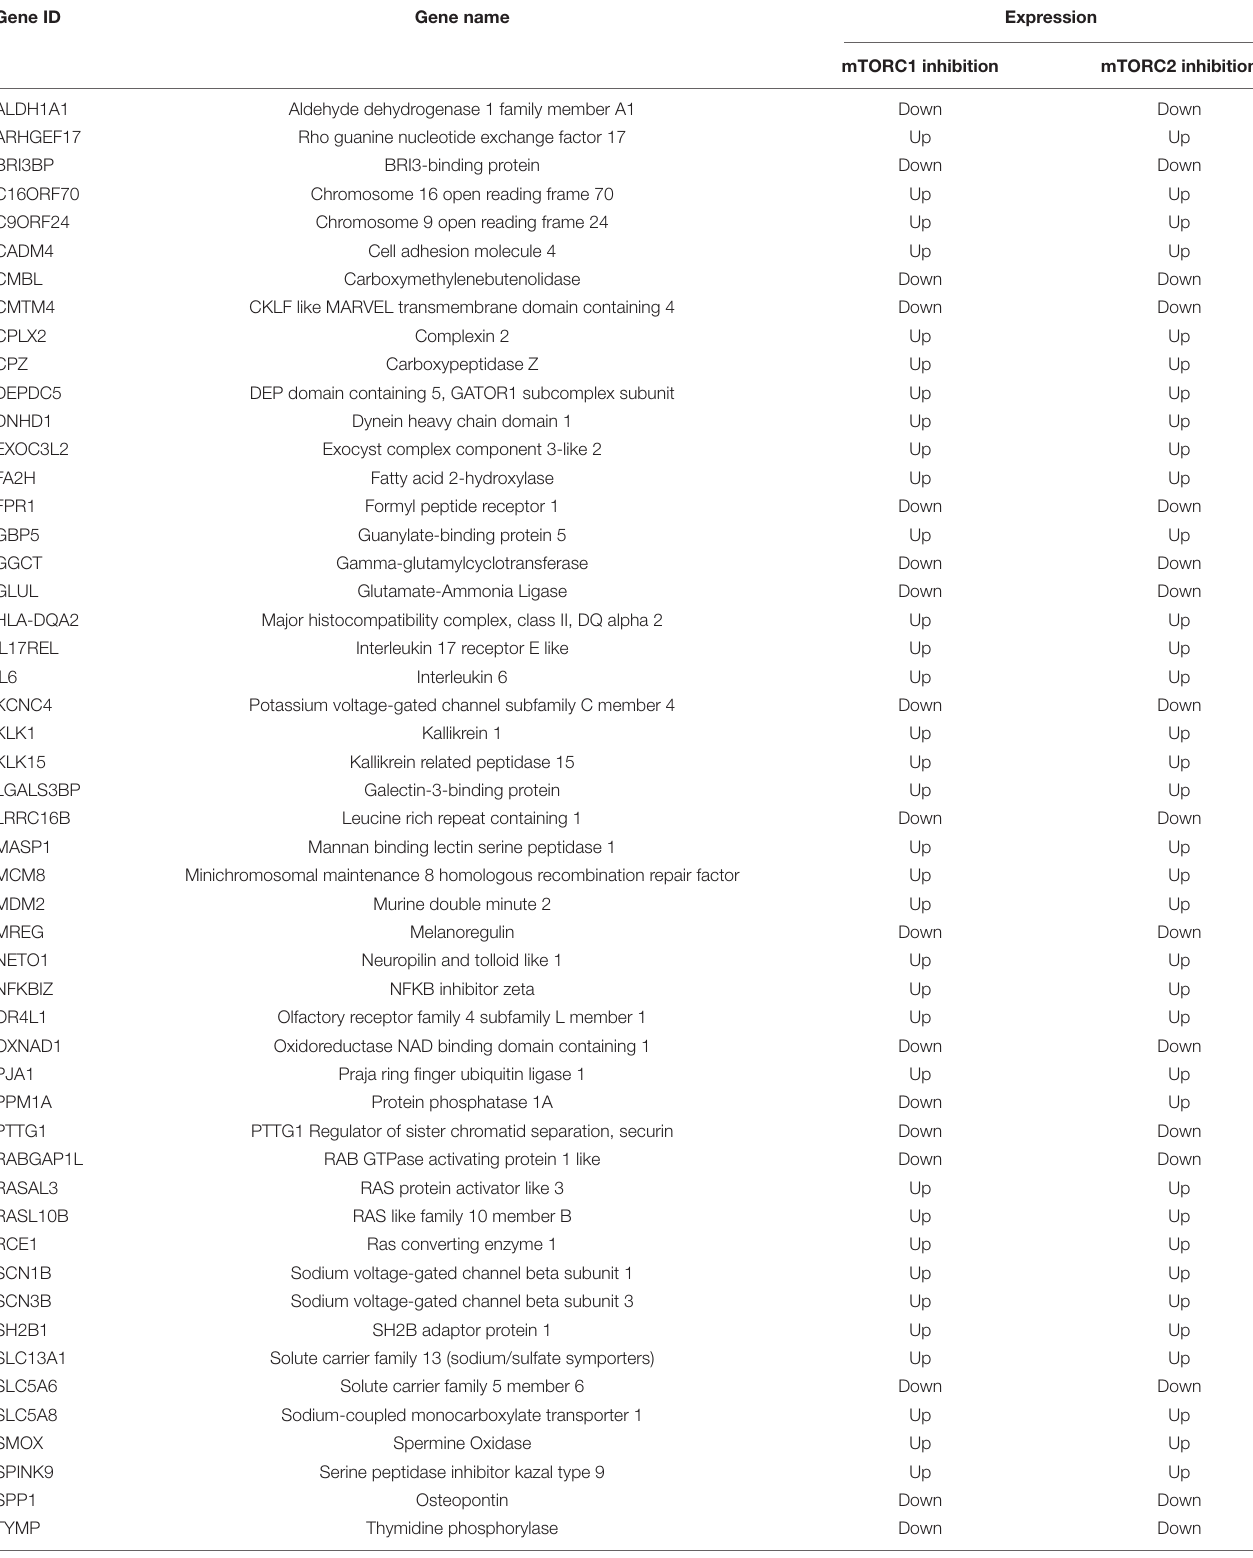
TABLE 6 | List of common DEG’s between mTORC1 and mTORC2 inhibited PHT cells. Gene